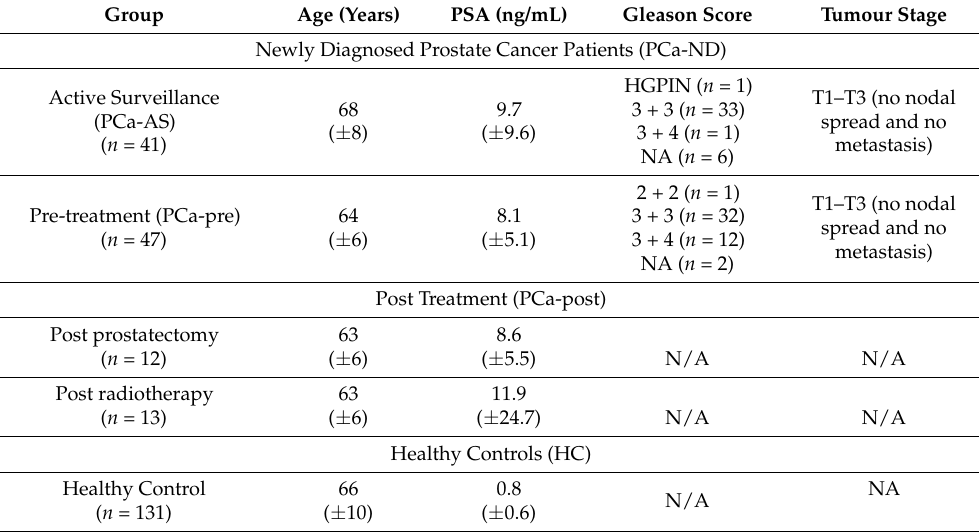
Table 1. Clinical profile of patients enrolled and analysed in the study. Patients were segregated into newly diagnosed (PCa-ND) and post-treatment (PCa-post) PCa patients. PCa-ND were composed of individuals put on active surveillance (PCa-AS) or referred for further treatment (PCa-pre) at time of diagnosis. PSA: prostate-specific antigen, HGPIN: high-grade prostatic intraepithelial neoplasia, NA: not applicable. Where specified, ± determines standard deviation, and n represents the number of individuals in each